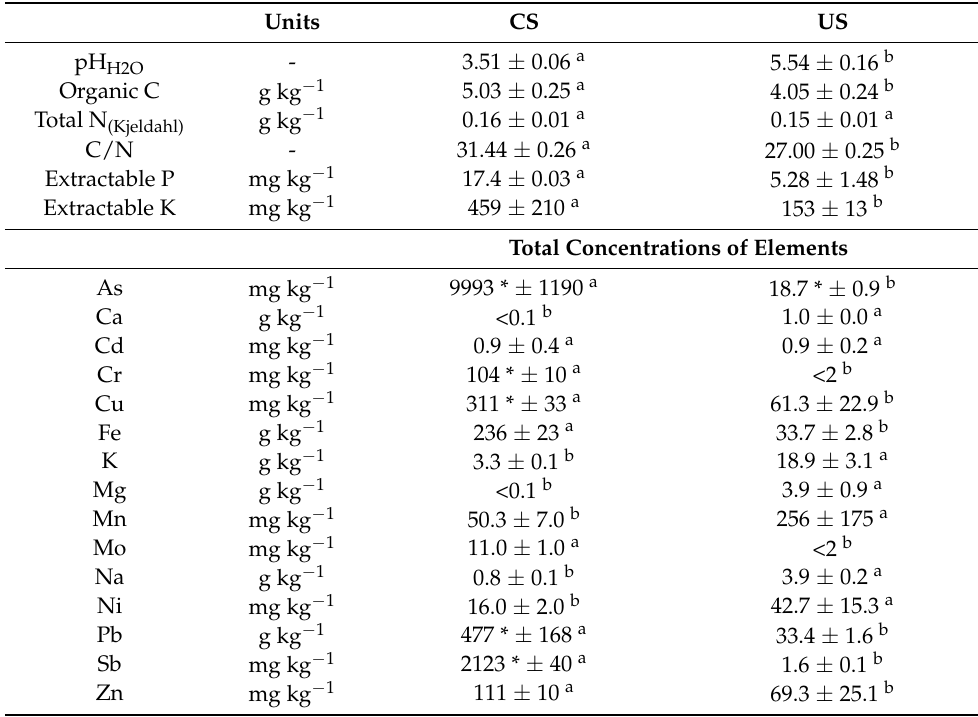
Table 1. Characteristics and multielemental total concentration ( ± standard error) in the contaminated soil from S ã o Domingos (CS) and the uncontaminated soil from Caldeir ã o